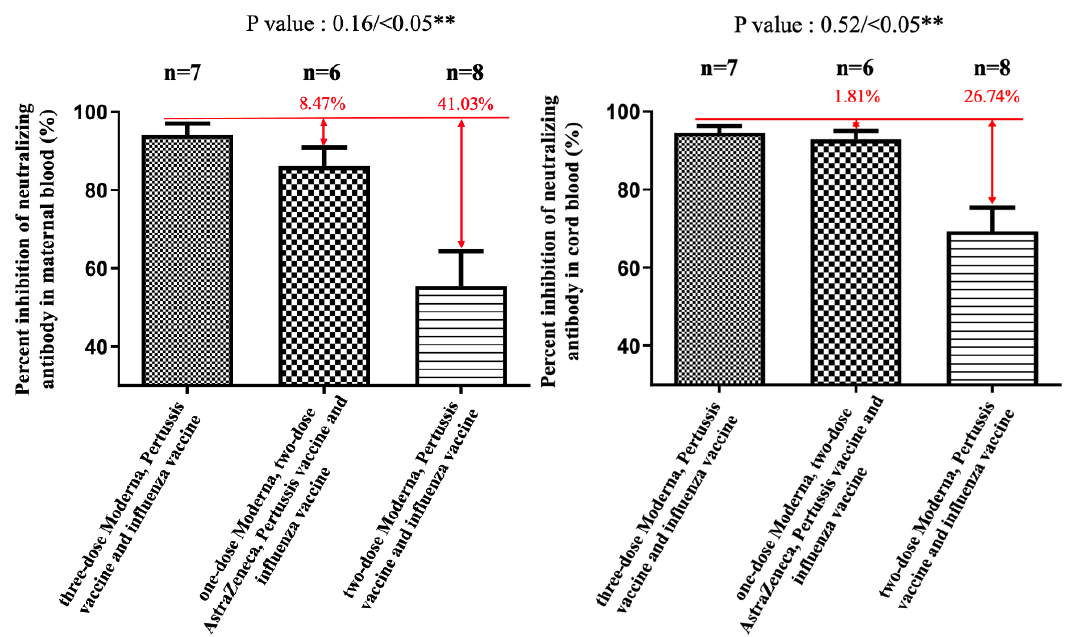
Figure 2. The percentage neutralizing antibody inhibition against the Delta variant in maternal and cord blood. In the two-dose AZ plus one-dose Moderna group, there was an 8.47% reduction ( p = 0.16) in maternal blood and a 1.81% ( p = 0.52) reduction in cord blood compared with the three-dose Moderna group. In the two-dose Moderna group, there was a 41.03% reduction ( p < 0.05) in maternal blood and a 26.74% ( p < 0.05) reduction in cord blood compared with the three-dose Moderna group. **indicates statistically significant.